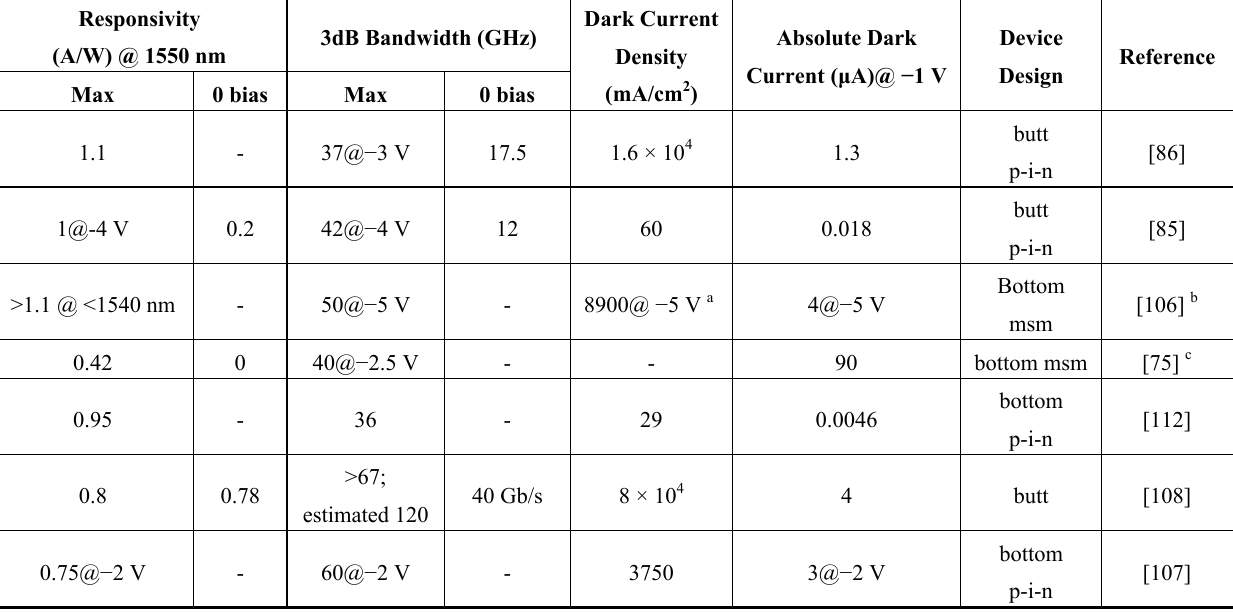
Table 1. Summary of waveguide-coupled Ge-on-Si PD performance. All devices are fabricated by epitaxial growth on Si and performance data are reported for − 1 V reverse bias, unless otherwise